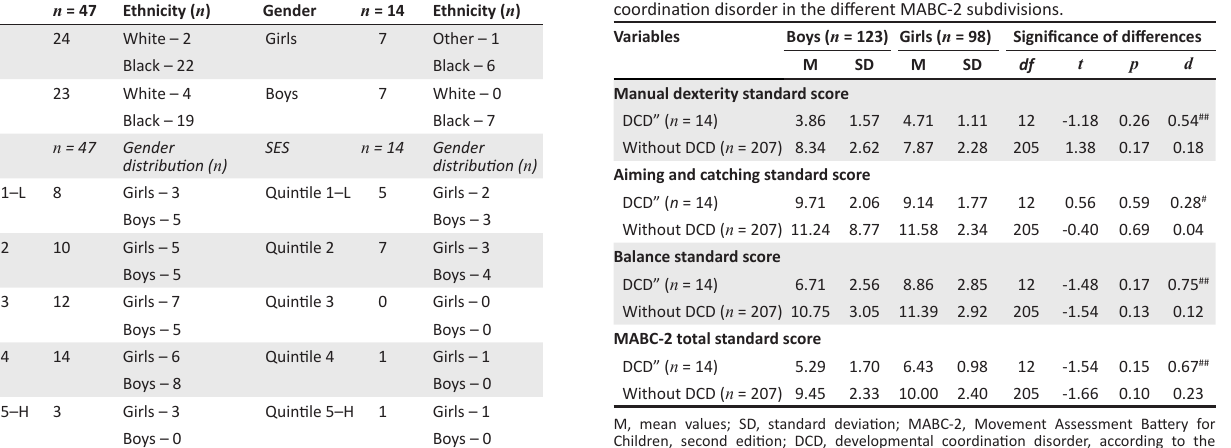
TABLE 2: Demographics of learners with developmental coordination disorder according to the Diagnostic and Statistical Manual of Mental Disorders, fifth edition diagnostic